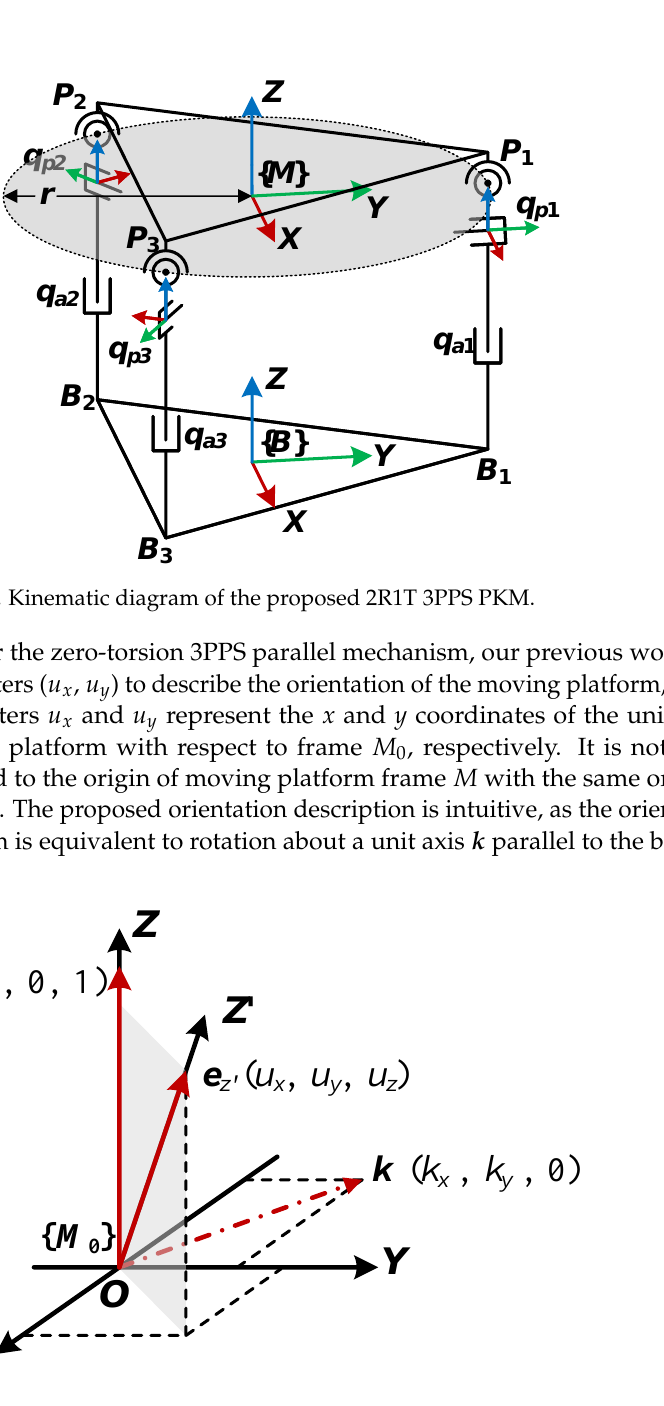
Figure 3. Equivalent rotation about a unit axis k parallel to the base plate. Based on the zero-torsion motion characteristic of the 3PPS PKM, the rotation matrix is simplified as follows: B R = M where R ij denotes the entry in the i th row and j th column of the rotation